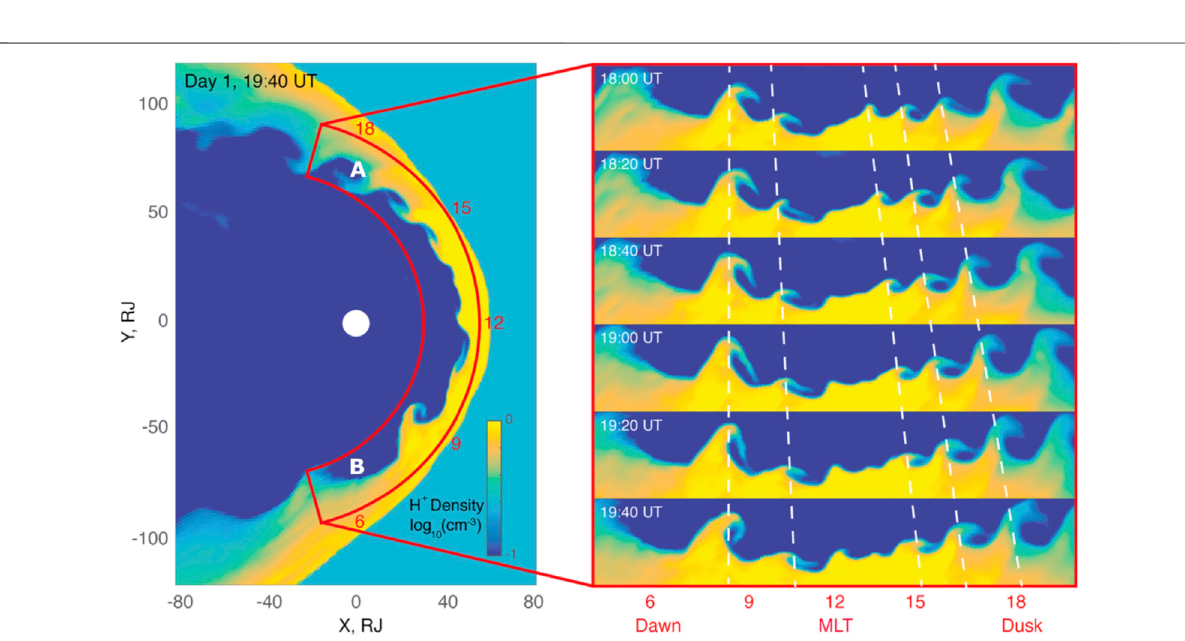
Frontiers in Astronomy and Space Sciences |